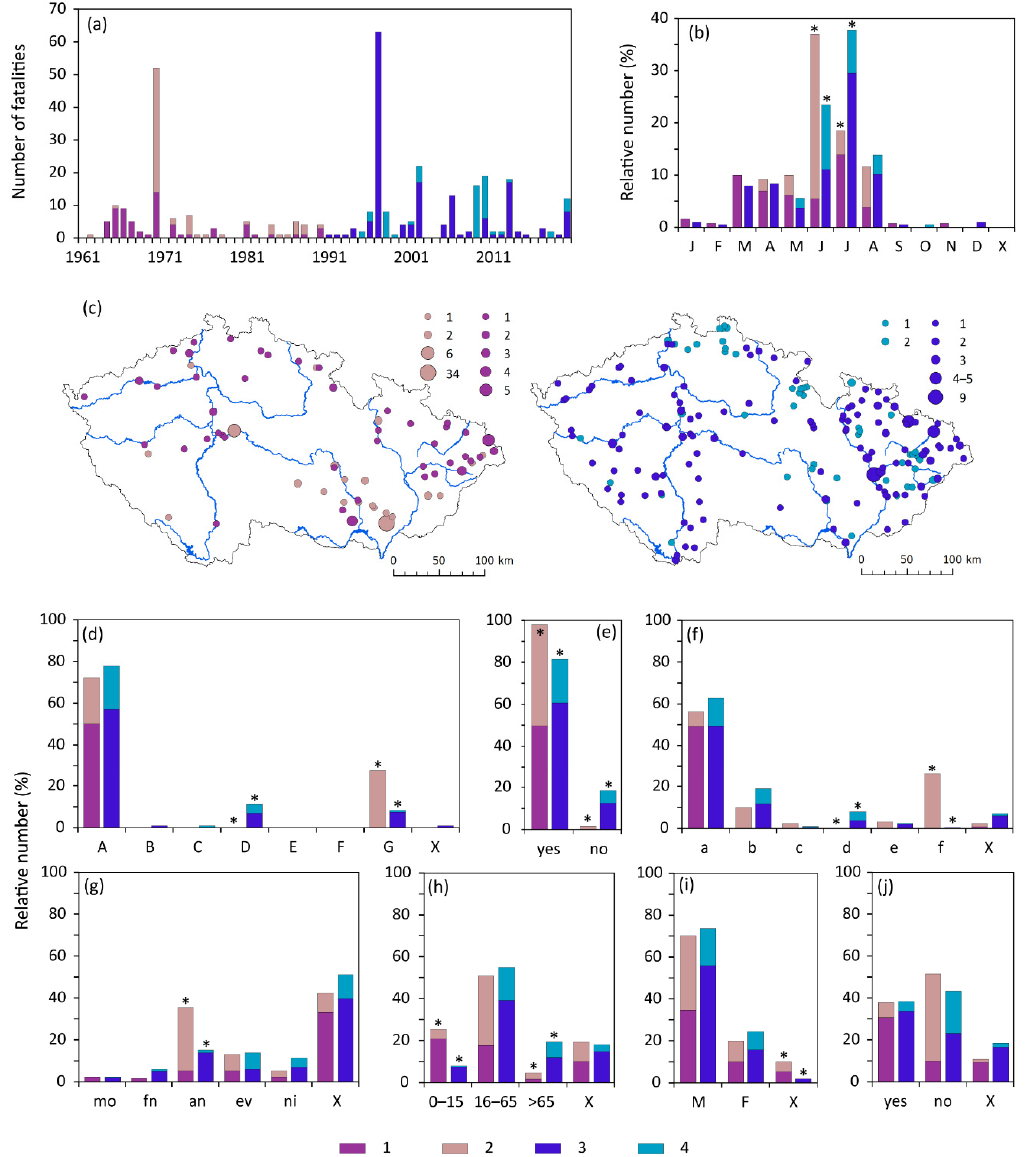
Figure 2. Characteristics of flood-related fatalities in the Czech Republic during the